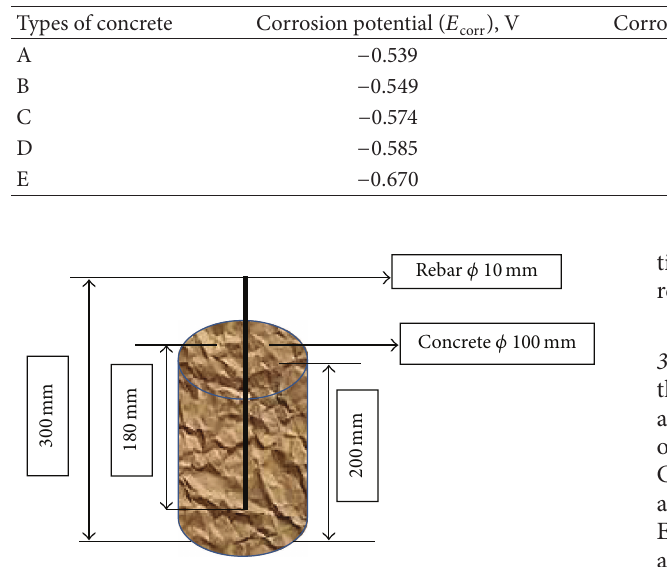
Figure 1: Experiment setup of the corrosion